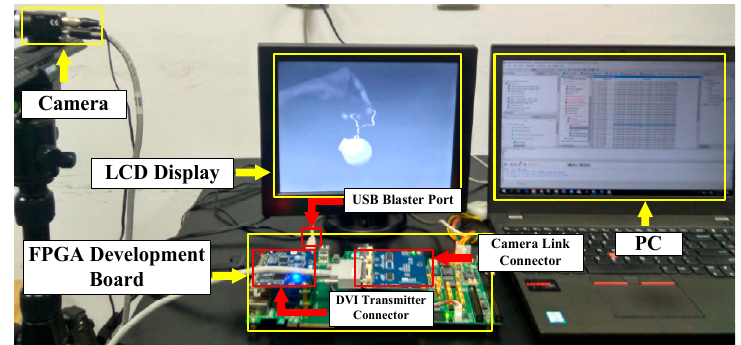
Figure 5. A prototype of the image compression system based on the proposed vector quantizer.